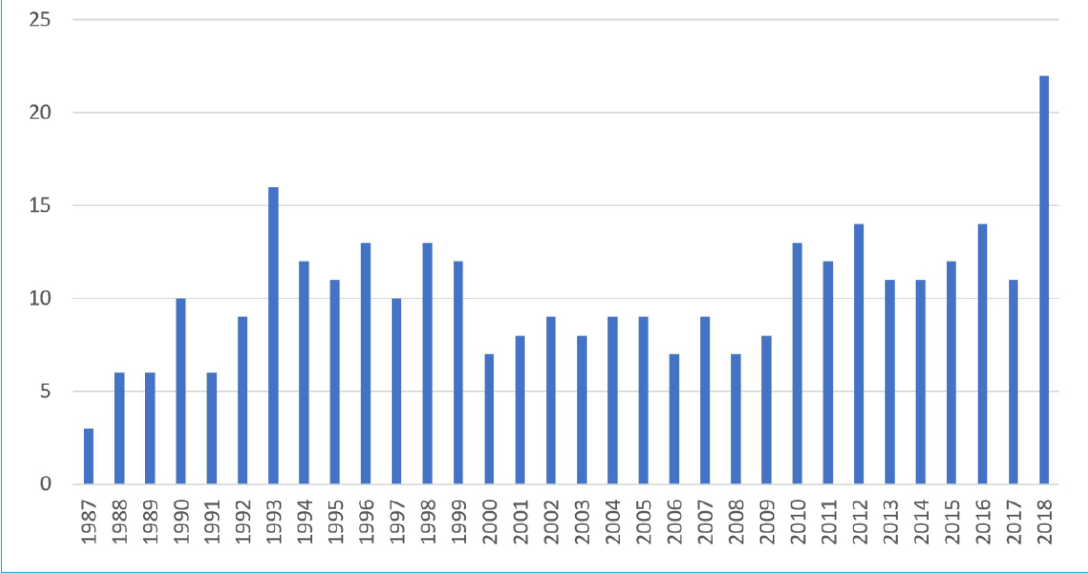
Figure S1: Number of annual heart transplantation operations from 1987 to 2018. Bars represent absolute numbers.